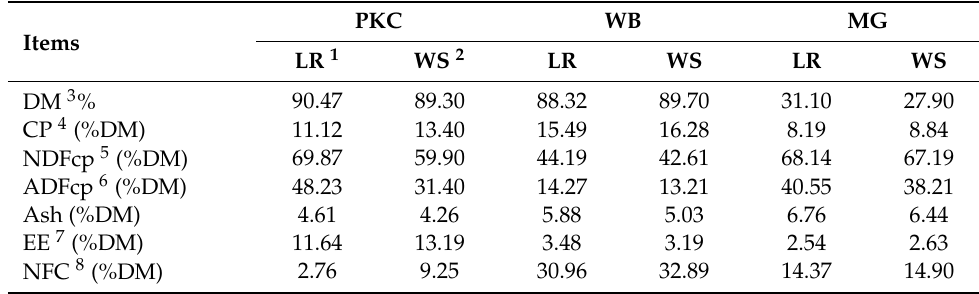
Table 1. Chemical composition of the ingredients of the experimental